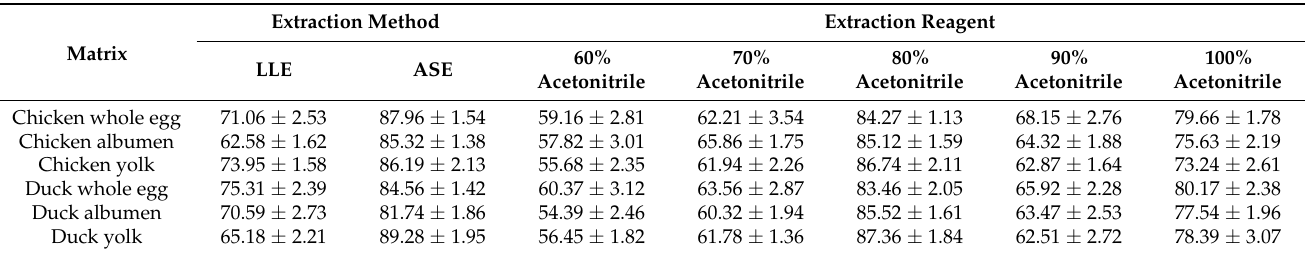
Table 2. Effect of extraction method and different extraction reagents on the recovery of penicillin G in poultry eggs (%) ( n =